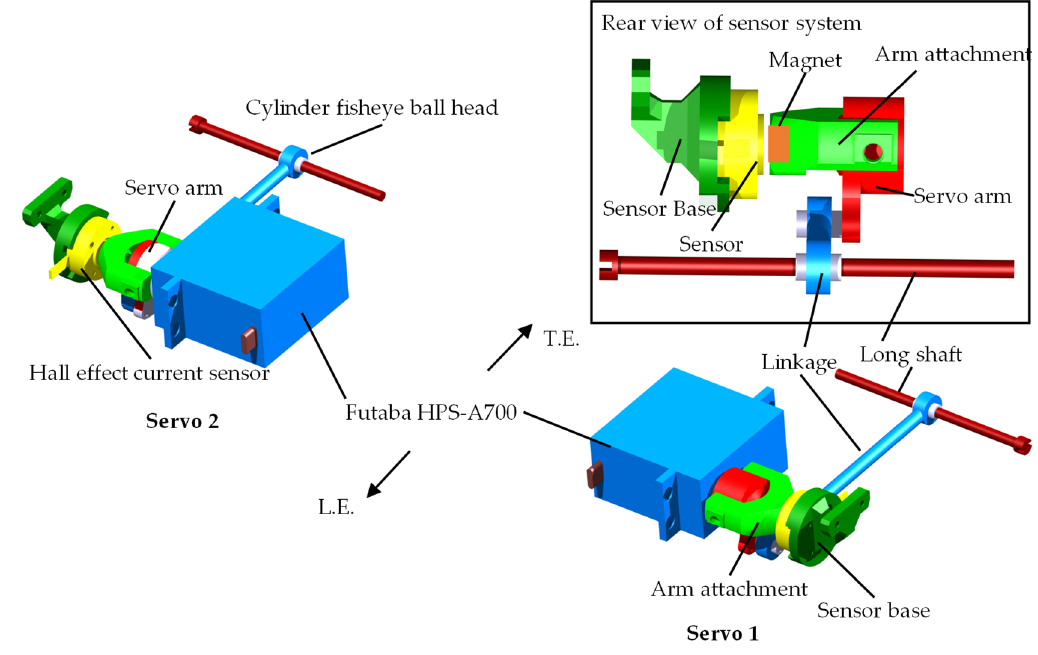
Figure 9. Actuation and sensor subsystems of mTE4.